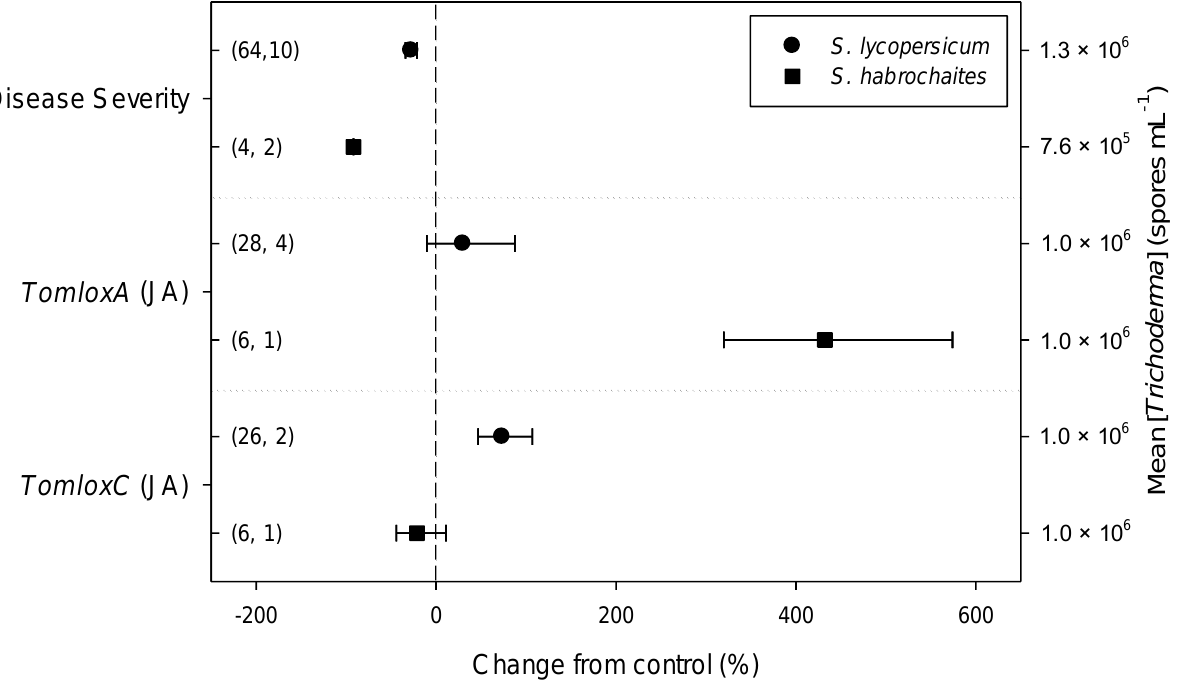
Figure 2. Differential effects of Trichoderma on Botrytis cinerea infection (i.e., disease severity) and defense-related genes involved in jasmonic acid (JA; i.e., tomato lipoxygenase A and C, TomloxA and TomloxC ) pathway in tomato leaves on the basis of tomato species ( Solanum lycopersicum and S. habrochaites ). Symbols represent the mean percentage change due to Trichoderma treatment relative to control (i.e., B. cinerea infection without Trichoderma treatment), and the bars show the 95% confidence interval. Number of observations and papers are shown in parentheses; mean Trichoderma spp. concentrations are given along the right y axis.